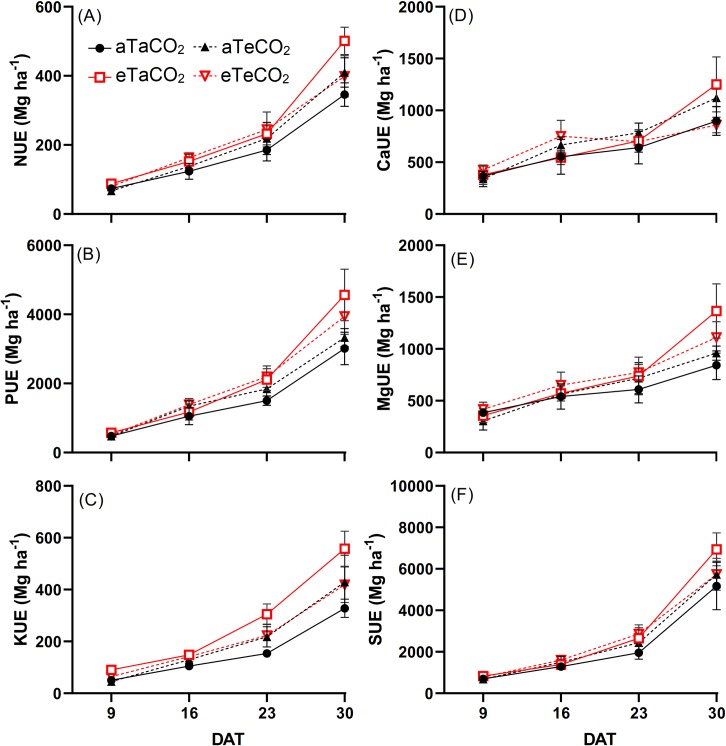
N (A), P (B), K (C), Ca (D), Mg (E) and S (F) use efficiency of P. maximum shoot during the experiment at 9, 16, 23 and 30 days after treatments (DAT). Treatments: aTaCO2 (ambient temperature and ambient [CO2]), eTaCO2 (2°C above ambient temperature and ambient [CO2]), aTeCO2 (ambient temperature and 200 ppm above ambient [CO2]), and eTeCO2 (2°C above ambient temperature and 200 ppm above ambient [CO2]). Bars show means and SE of four replicates.